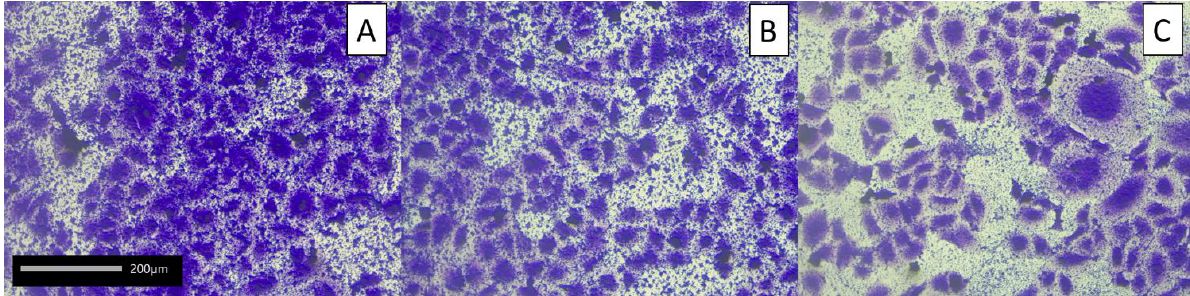
Figure 4. Selected microphotographs showing adhesion of lactic acid bacteria to Caco-2 cells: ( A ) L. plantarum 18/1, ( B ) L. plantarum 21/1, and ( C ) P. acidilactici 25/1 (objective 20×). Observed under a phase-contrast microscope (Nikon Eclipse Ci H600L, Tokyo, Japan) attached to a digital camera (NikonDigital Sight DS-U3, Tokyo, Japan) and imaging software (NIS-elements BR 3.0, Nikon, To- kyo, Japan).